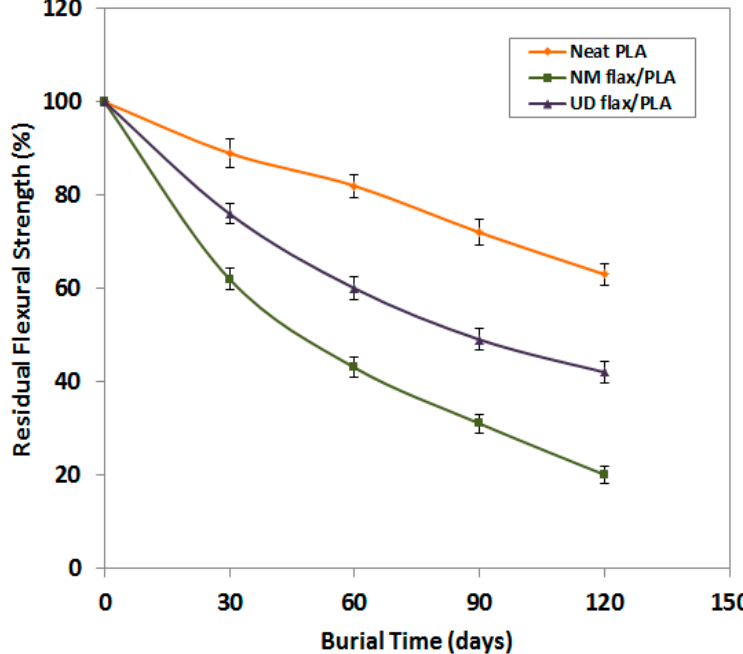
Figure 12. Comparative residual flexural strength of biodegraded composites.